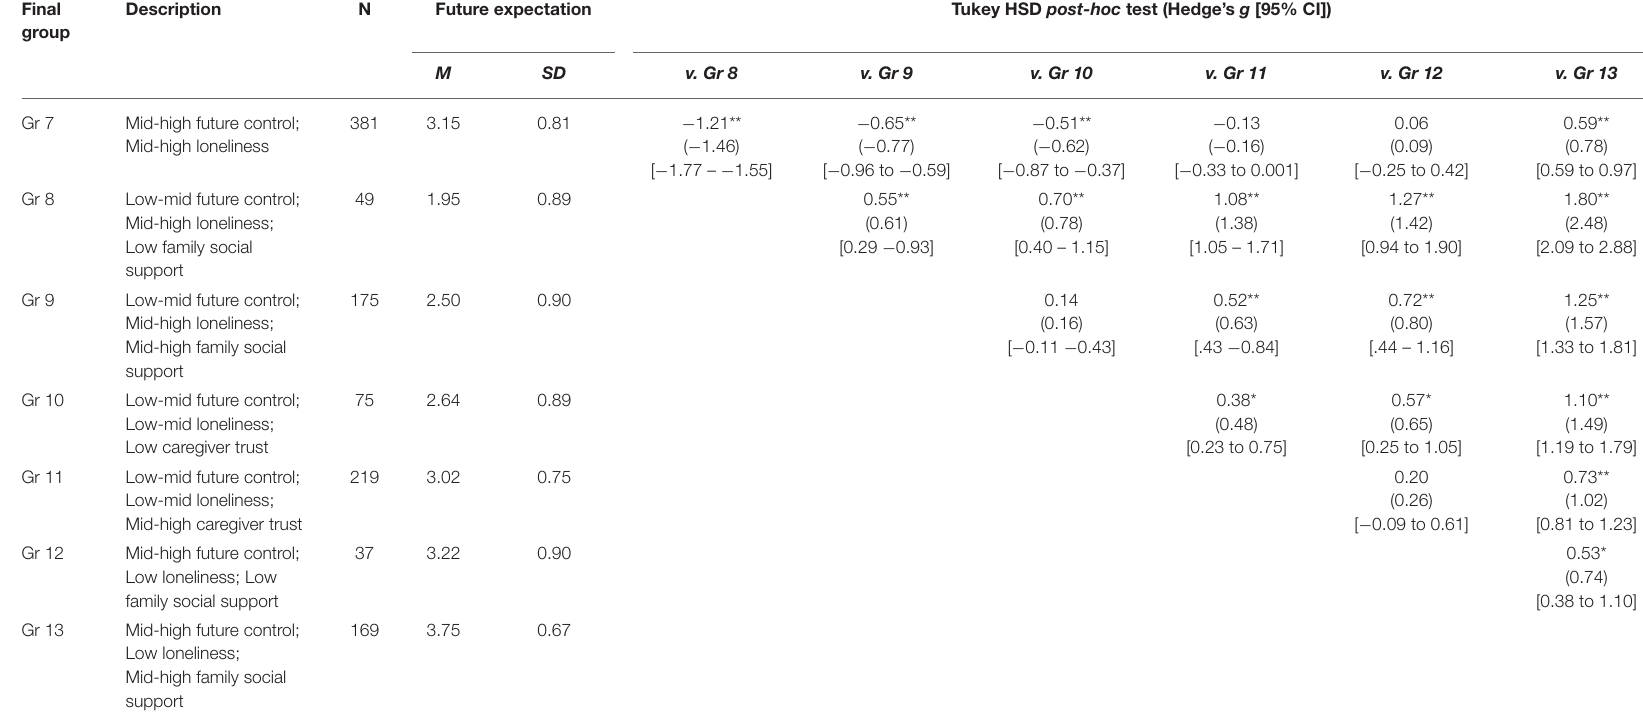
TABLE 3 | SEARCH-ing for future expectation: final search groups, descriptive statistics, and mean